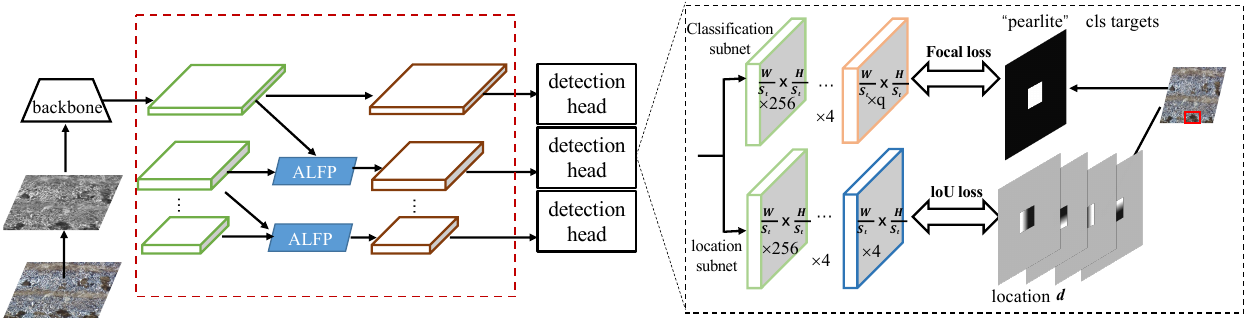
Figure 3. The network architecture of self-adaptively attention-aware soft anchor-point